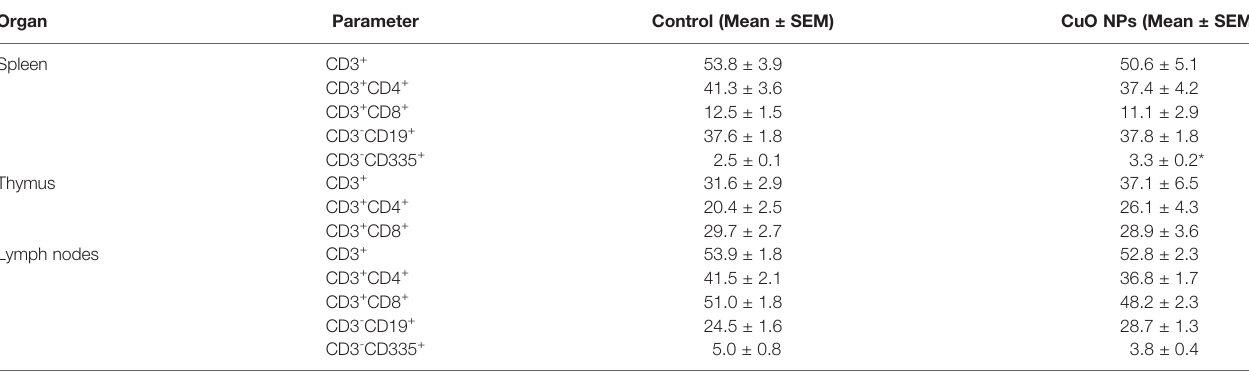
Organs were derived from mice exposed to CuO NPs for 6 weeks and controls. Cells were labelled with fl uorescent monoclonal antibodies and analyzed using fl ow cytometer. Control – controlgroup(n=9),CuONPs – groupexposedtoCuONPs(n=8).CD3 + – T-lymphocytes,CD3 + CD4 + – T-helperlymphocytes,CD3 + CD8 + – T-cytotoxiclymphocytes,CD3 - CD19 + – B- lymphocytes, CD3 - CD335 + – NK-cells. Results are expressed as the mean group percentage of labelled cells (mean ± SEM). Signi fi cance: *p < 0.05.